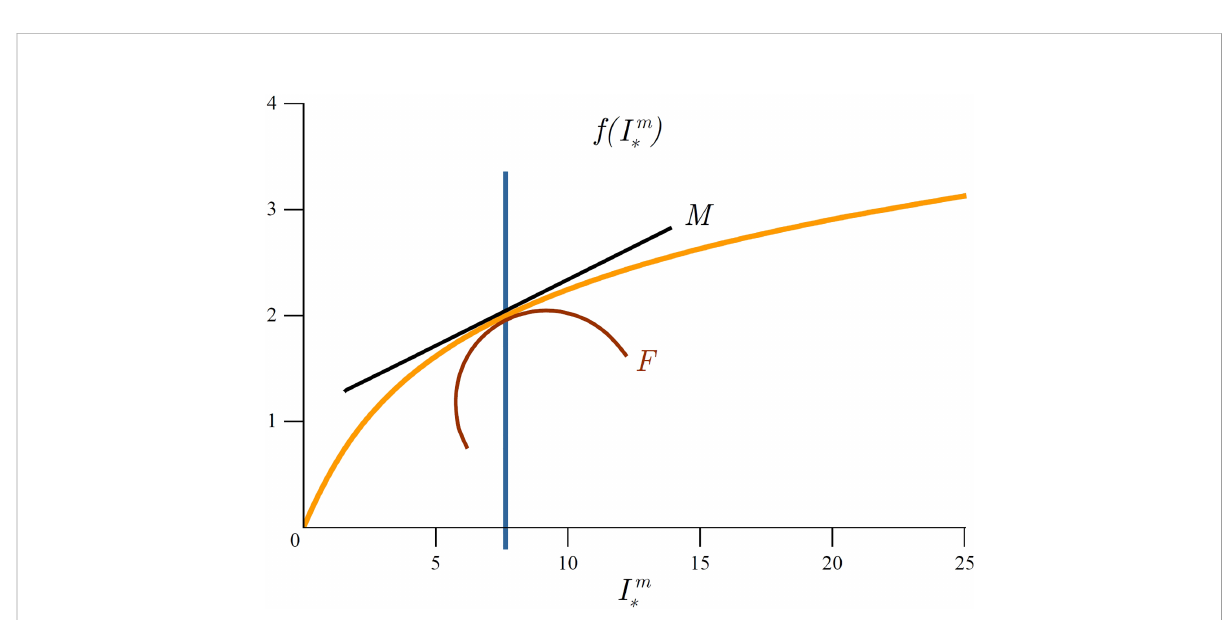
FIGURE 2 Graphical representation of marginal watercolumn production and watercolumn production fragility. The orange curve is the f ð I m * Þ function (ordinate, dimensionless) from the canonical solution (10) for watercolumn production (Platt et al., 1990). Marginal watercolumn production M I equals the fi rst derivative of f ð I m * Þ with respect to I m * (black line). Watercolumn production fragility F I equals the second derivative of f ð I m * Þ with declines and we say watercolumn production is respect to I m * (red curve). I m * is the scaled noon irradiance (dimensionless). As I m * increases M I fragile with respect to irradiance F < I